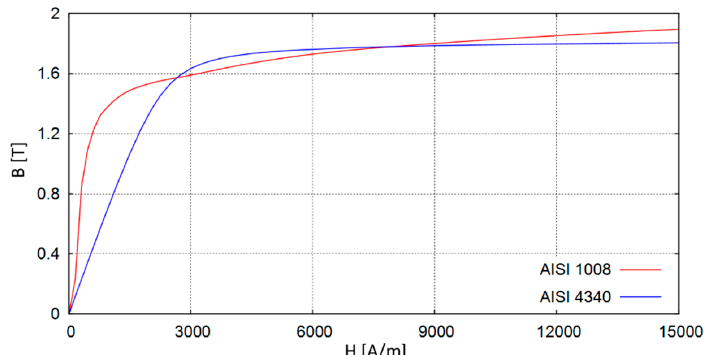
Figure 3. Magnetic characteristic of the soft steels.